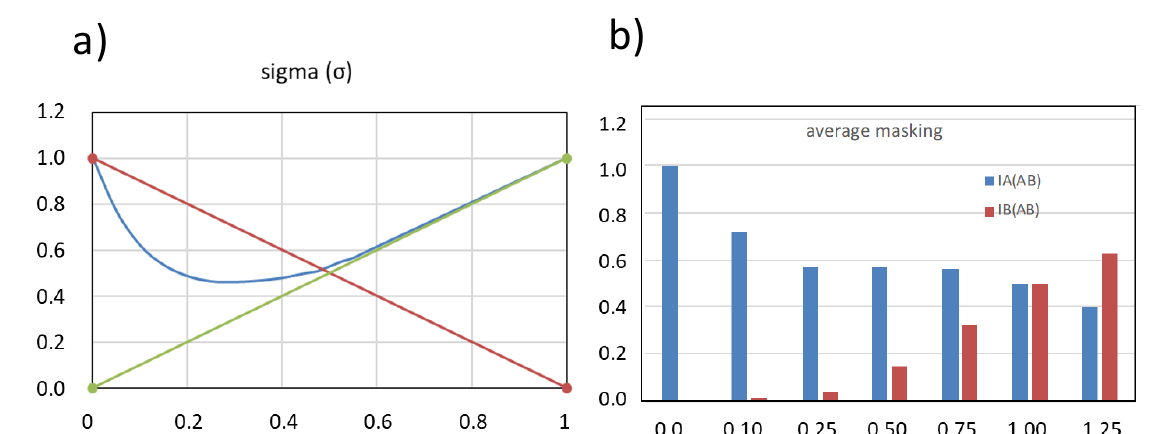
Figure 5. Destructive interactions. ( a ) corresponds to the σ − τ plot of a mixture of 2 odours displaying strong compromise effects (the addition of B on A has as a result a net decrease of the odour intensity. ( b ) shows the odour intensities of the two component odours ( I A / AB and I B / AB ) in mixtures containing a fixed amount of A ( I A = 1) and increasing amounts of B (from I B = 0 to I B = 1.25). For this plot a sigmoid with a = 0.30 (average masking effect) and b = 0.50 (perfect symmetry) was considered.